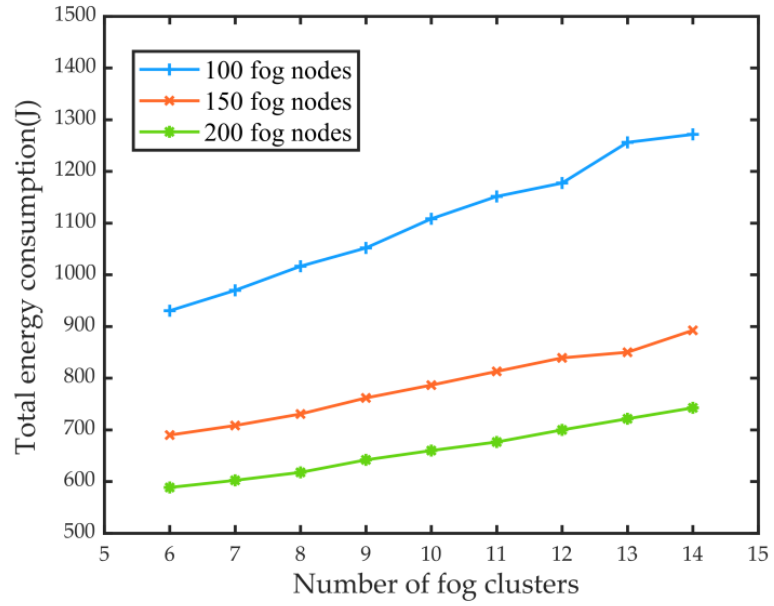
Figure 8. Total energy consumption versus fog cluster number in three environments.